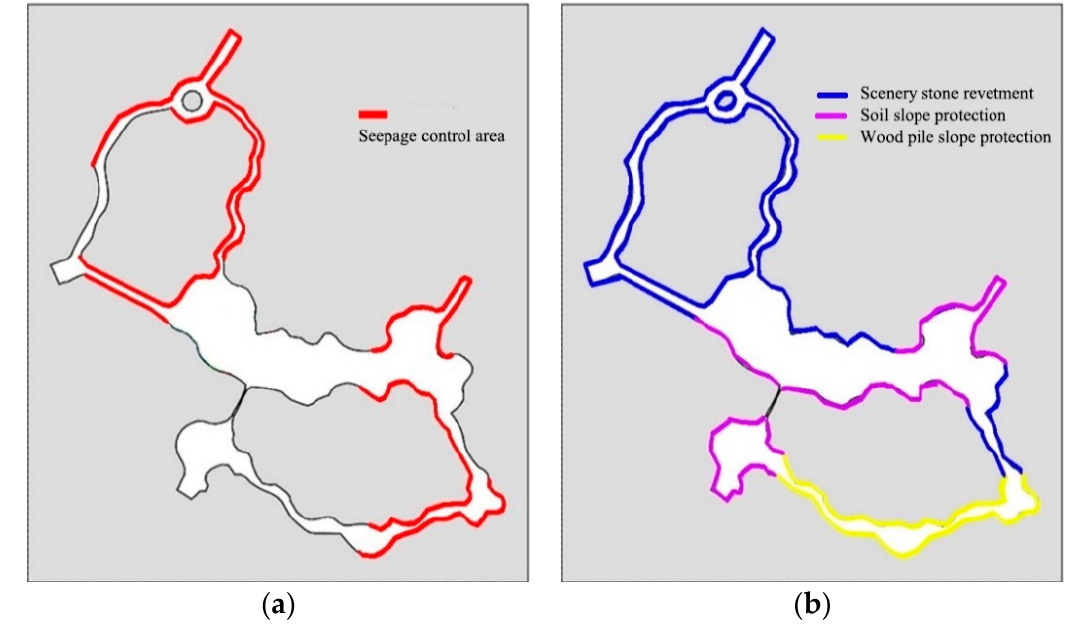
Figure 11. ( a ) River seepage control area. ( b ) River slope protection type.